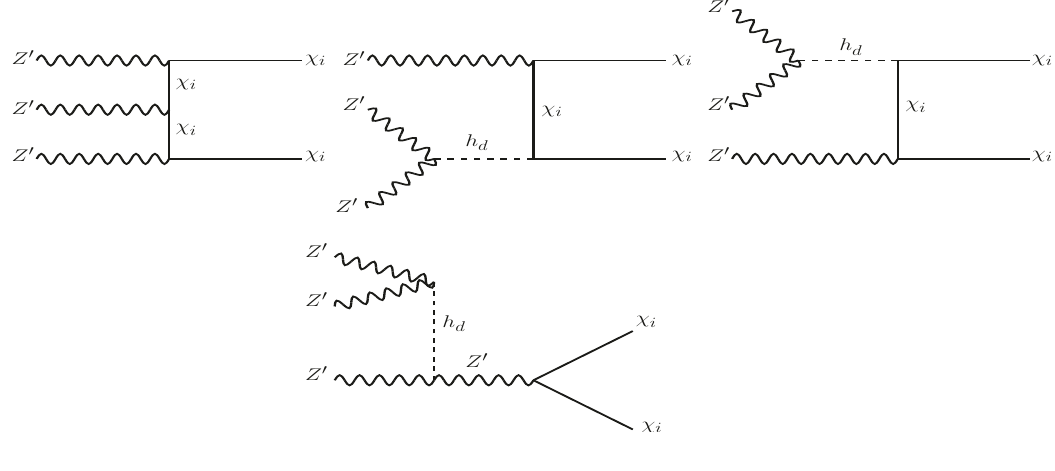
Figure 25 . Feynman diagrams for Z 0 Z 0 Z 0 → χ